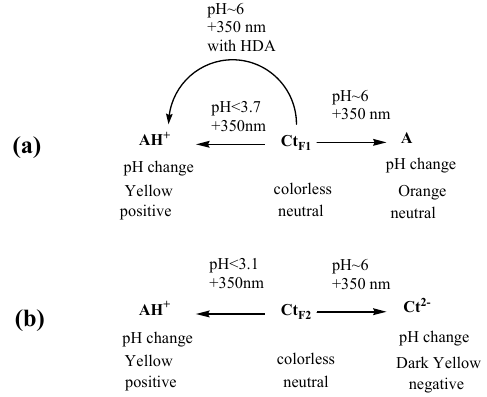
Figure 11. Orthogonal response of Ct for F1 ( a ) and F2 ( b ) with two signals, pH and light. Supplementary Materials: The following supporting information can be downloaded at https:// www.mdpi.com/xxx/s1, Figure S1: Mass spectrum of F1 . Figure S2: Mass spectrum of F2 . Figure S3: 1 H-NMR spectrum of F1 in MeOD-d4/TFA-d=95/5. Figure S4: 13 C-NMR spectrum of F1 in MeOD- d4/TFA-d=95/5. Figure S5: 1 H-NMR spectrum of F2 in MeOD-d4/TFA-d=95/5. Figure S6: 13 C-NMR spectrum of F2 in MeOD-d4/TFA-d=95/5.